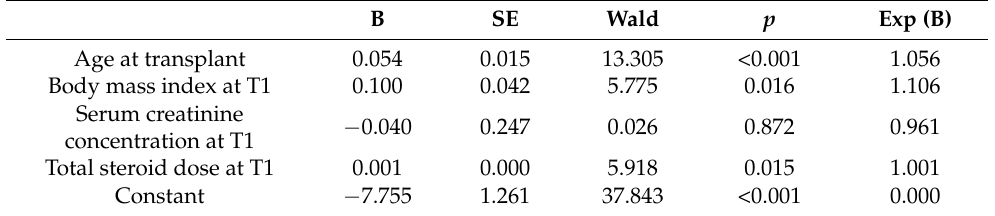
Table 4. Multivariate analysis for NODAT development during the first year after kidney transplantation. B SE Wald p Exp (B) Age at transplant 0.054 0.015 13.305 <0.001 1.056 Body mass index at T1 0.100 0.042 5.775 0.016 1.106 − 0.040 0.247 concentration at T1 0.001 0.000 1.001 − 7.755 1.261 37.843 <0.001